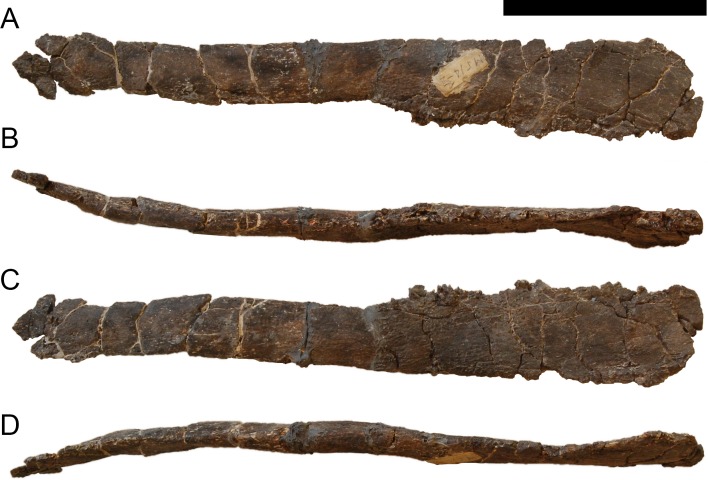
Sternal rib of Galeamopus pabsti SMA 0011.This bone can be attributed to morphotype E of Tschopp & Mateus (2013a). Orientation unknown. Scale bar = 10 cm.